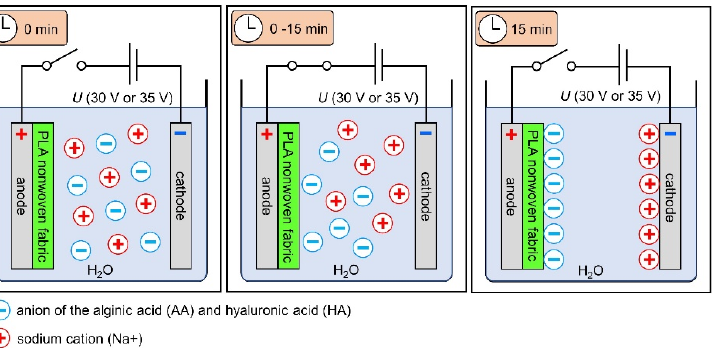
Figure 3. Scheme of surface modification of tested nonwovens. The figure was sourced and modi ‐ fied based on [1]. based on